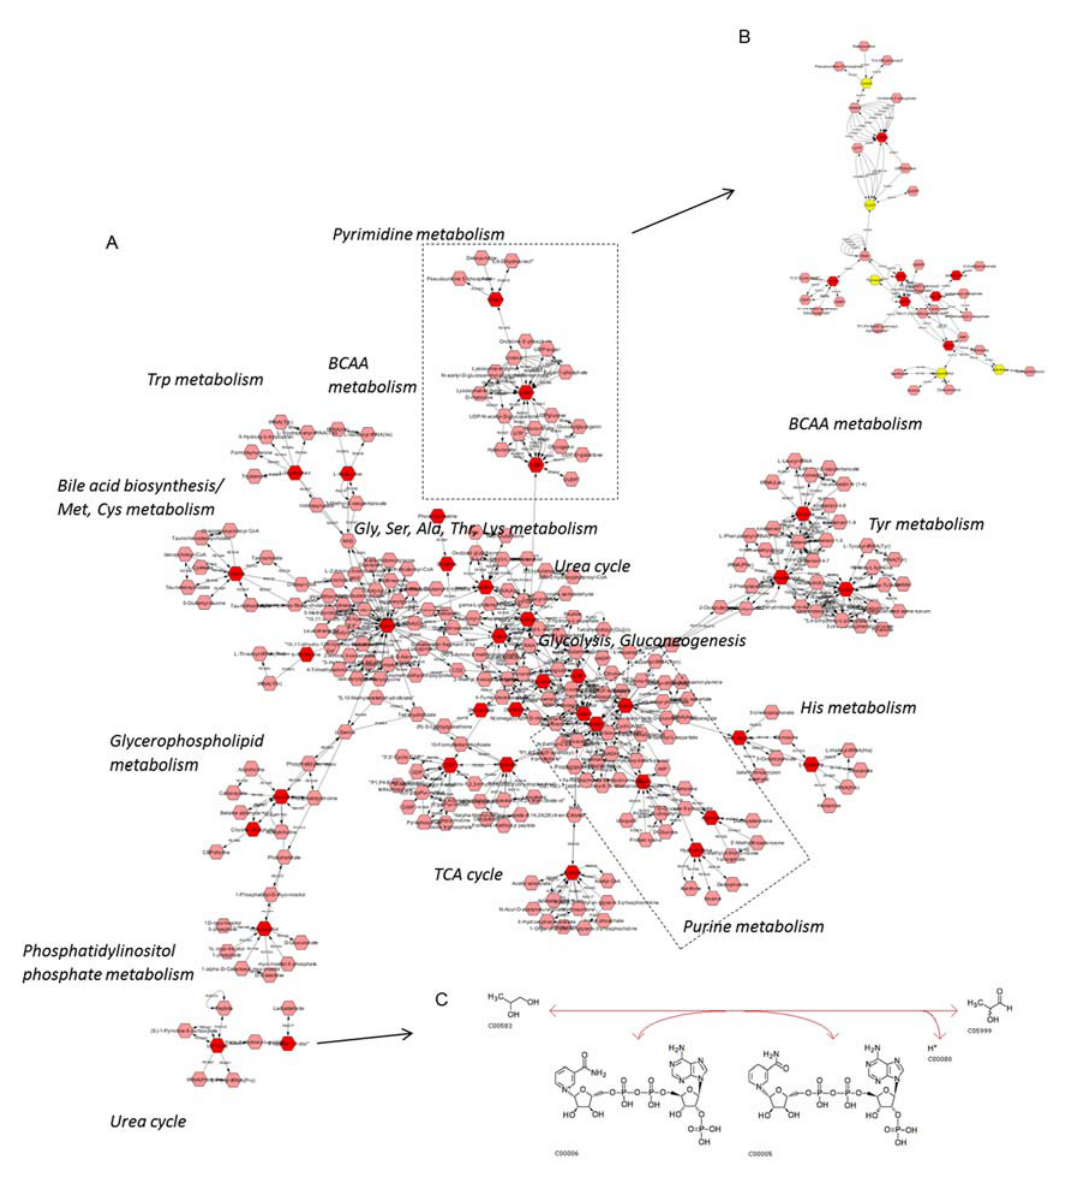
Figure 4 . UBC metabolic network construction. ( A ) Hits (red) of the 1 H NMR metabolomic analysis inserted into Cytoscape and the related pathways assembled. Purine/pyrimidine metabolism seems to play a crucial role in UBC progression. ( B ) Hits of the purine/pyrimidine metabolism in grade III (T24) versus grade I (RT4) cell group comparison. Red: increased in grade III (T24), Yellow: decreased in grade III (T24). ( C ) Propylene glycol (or propane ‐ 1, 2 ‐ diol) has emerged as a